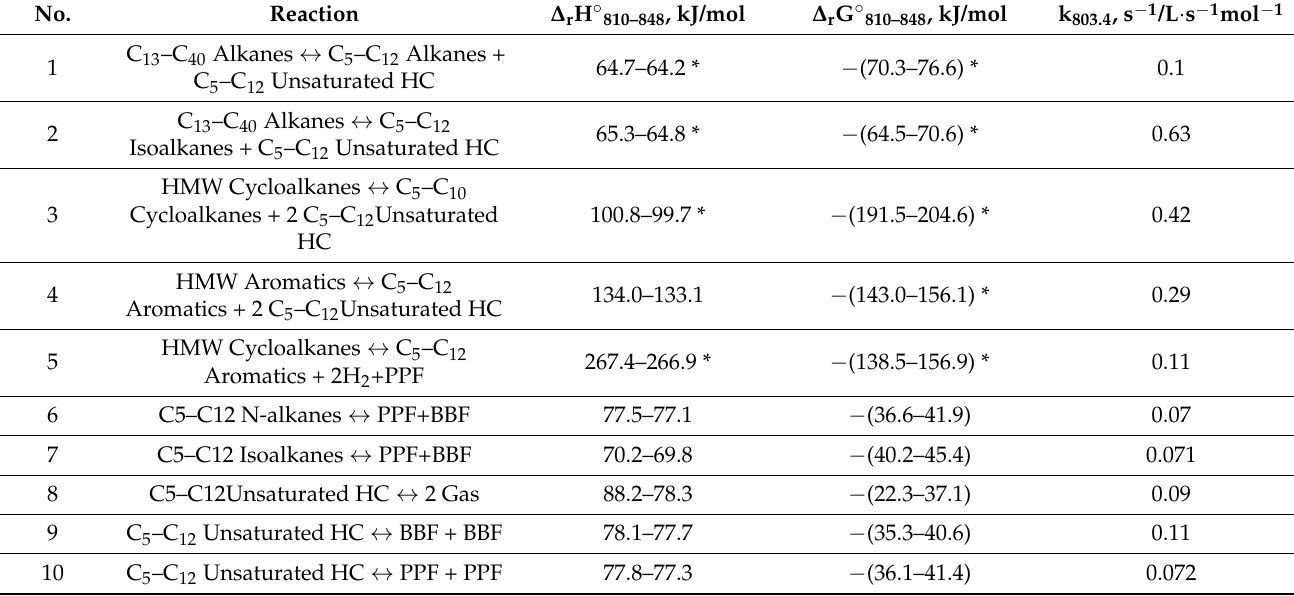
Table 4. The thermodynamic and kinetic patterns of catalytic